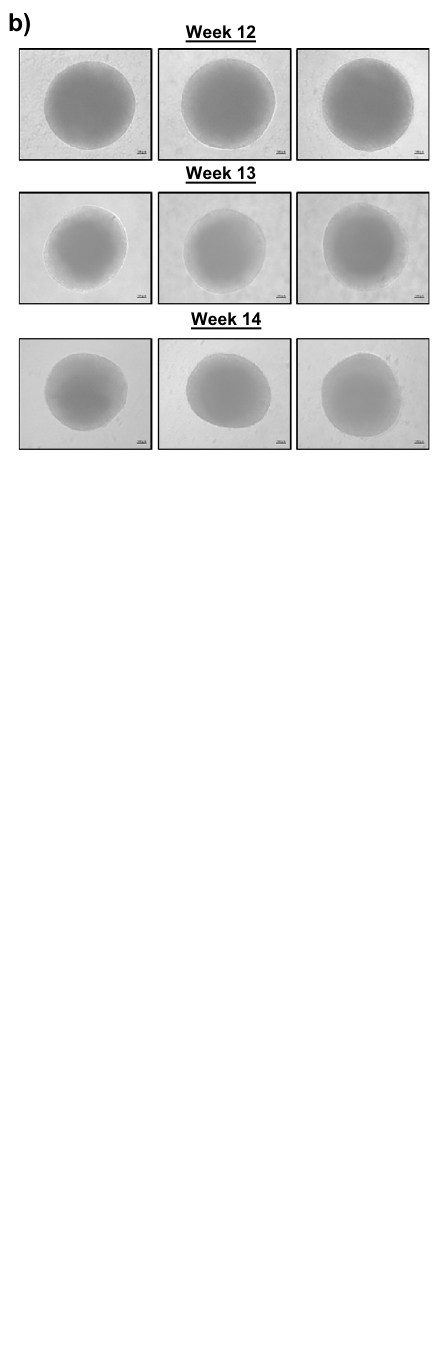
Figure 1. Generation and characterization of NPC-derived neurospheres. (a) General workflow and approximate timeline associated with the development of neurospheres using human somatic cells as the starting material. Figure created with BioRender.com. (b) Representative phase contrast images show the appearance and morphology of NPC-derived neurospheres during the course of the two week differentiation period (weeks 12 through 14). n = 3. Scale bar = 100 µm. (c) Average diameter (µm) of NPC-derived neurospheres (two measurements per sphere) during the course of the differentiation period. n = 3 neurospheres. (d) After the two week differentiation period (weeks 12 through 14), ICC staining was carried out on differentiated, cross-sectioned neurospheres. Nuclei were counter- stained with DAPI. Representative images show the relative expression of NPCs (SOX2), neurons (TH), astrocytes (GFAP), and microglia-like cells (IBA-1). Scale bar = 200 µm. n = 2 for ICC